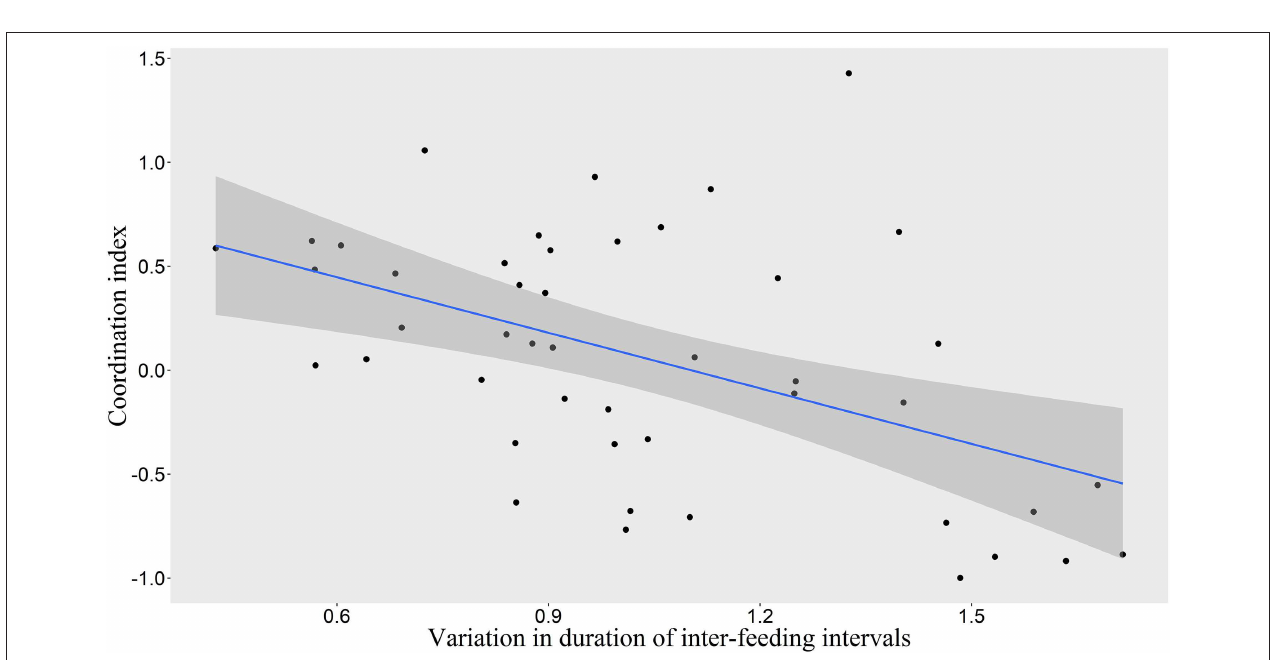
FIGURE 3 | Relationship between coordination index and variation in duration of inter-feeding intervals. Scatterplot with linear regression line (in blue) and 95% Confidence Interval (in shaded gray).